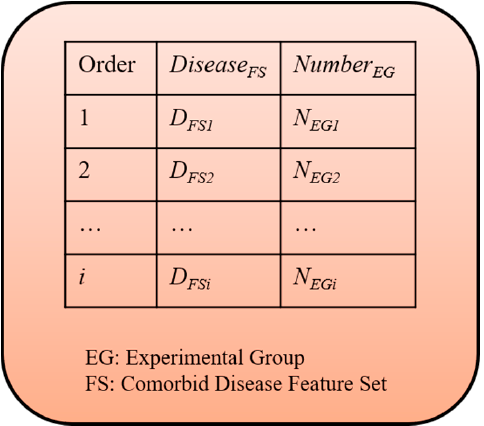
Figure 2. Illustration of the comorbidity feature set: Disease FS refers to comorbidity classification codes with odds ratios > 2. Number EG refers to the total number of subjects in the experimental group suffering from a specific disease. The number of subjects suffering from a specific disease in the comorbidity feature set is the same as the number of subjects in the disease set in the experimental group ( Number EG ).